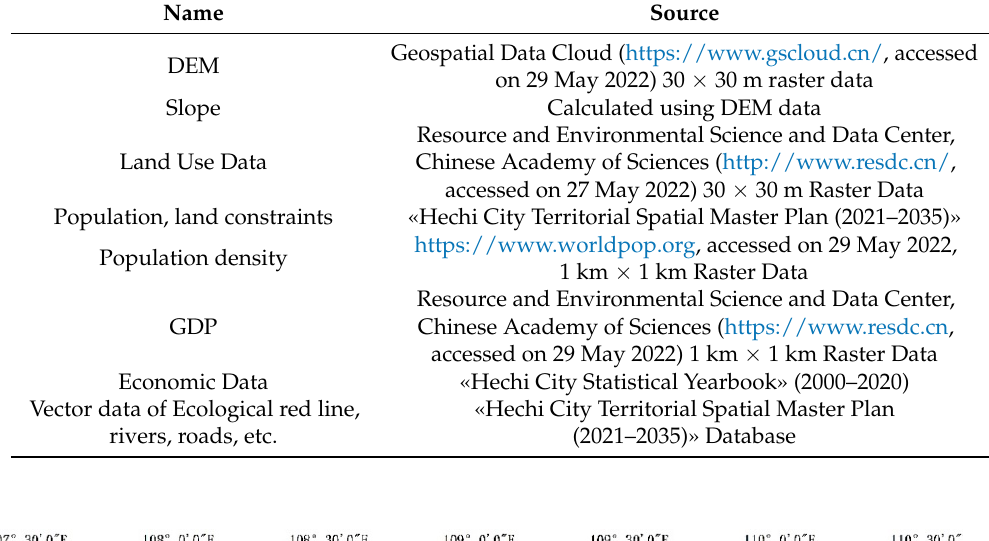
Table 1. Data source table.